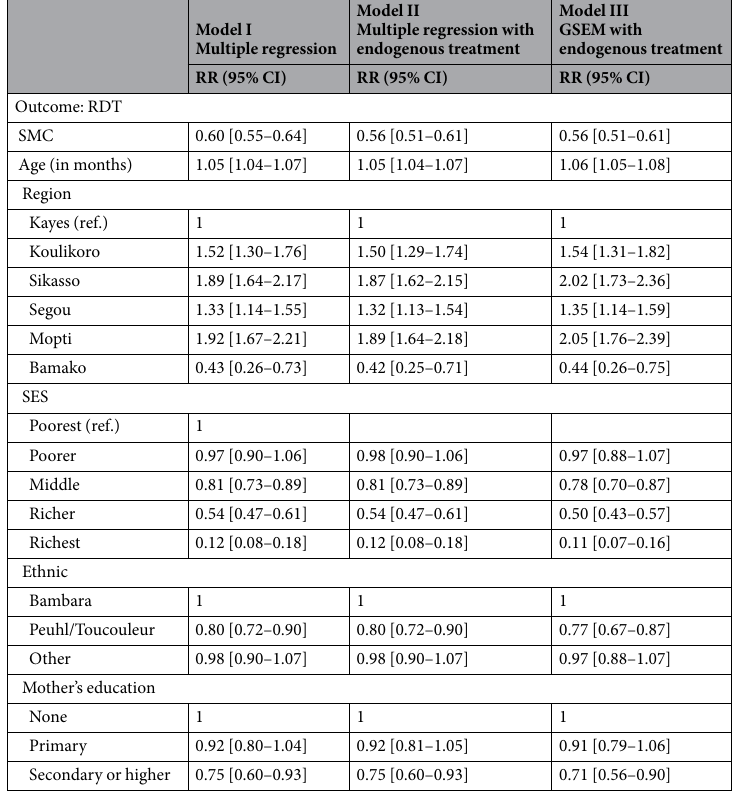
Table 2. Models of the effects of SMC on RDT-confirmed malaria. Wald test of no correlation between outcome and treatment equations (Model II): χ 2 = 15.56 ( < 0.001). RDT rapid diagnostic test; RR risk ratio;